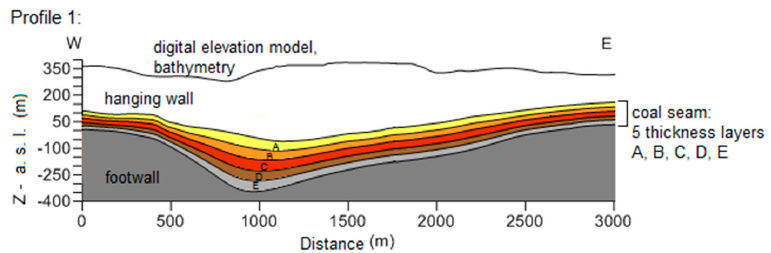
Figure 4. Profile 1 of coal seam defined with hanging wall ‐ coal layer ‐ footwall limits and divided into five thickness layers.